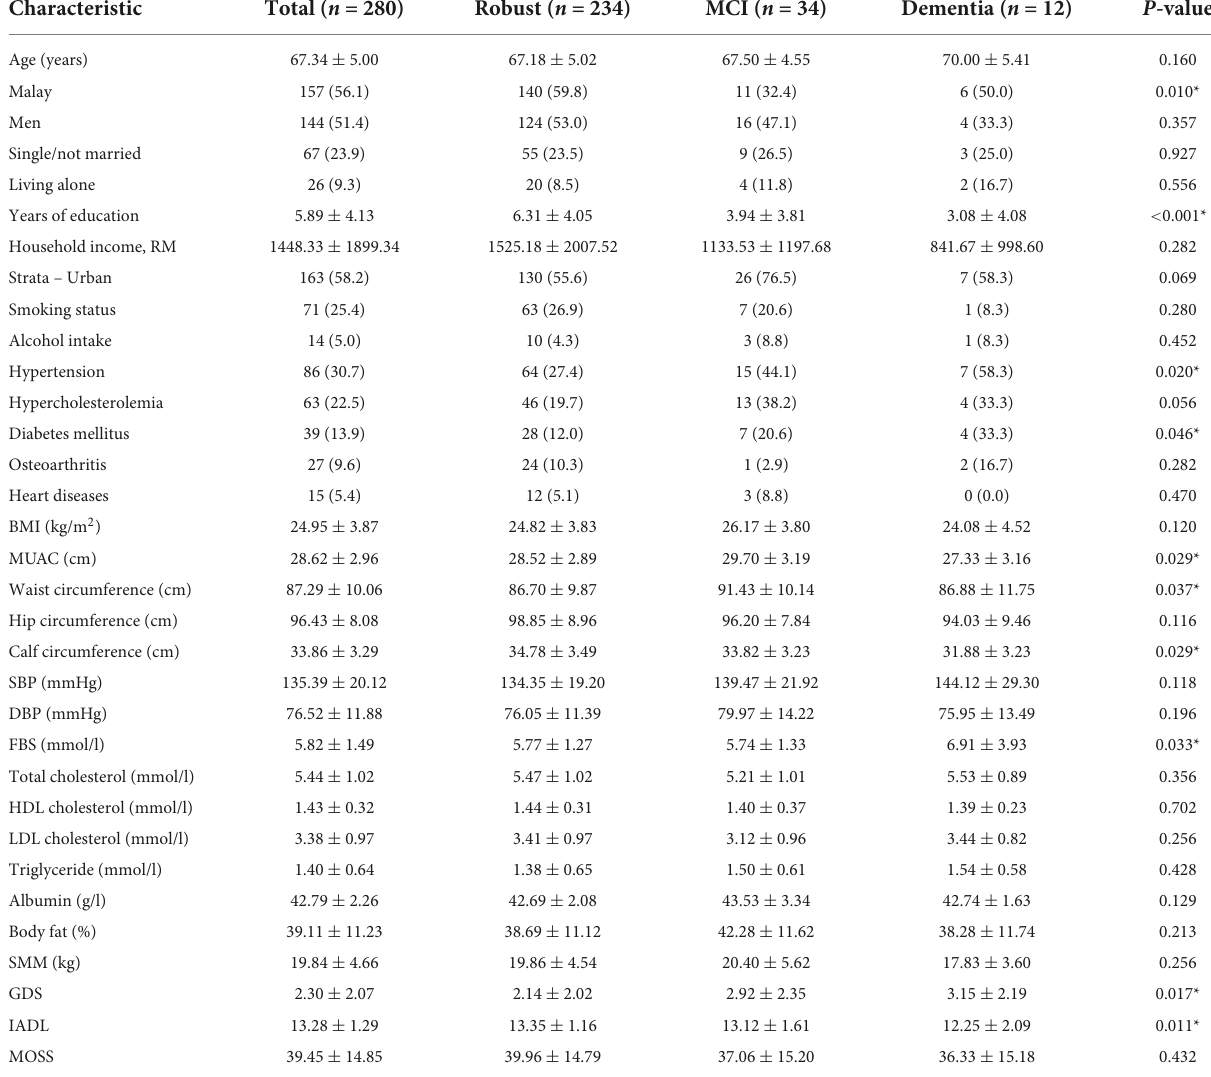
TABLE 2 Participant characteristics by tertile of the dietary pattern at baseline [presented as mean ± standard deviation (SD) or n (%)]. Characteristic Total ( n = 280) Robust ( n = 234) MCI ( n =